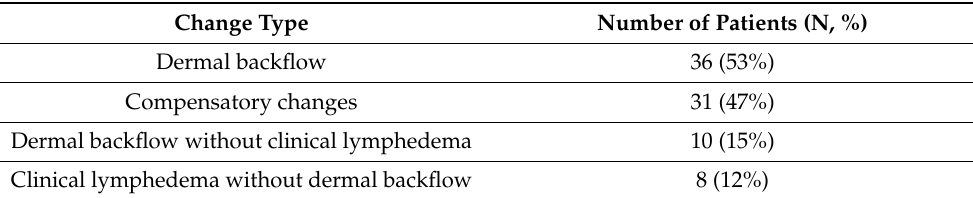
Table 3. Results of lymphoscintigraphy in breast cancer survivors.